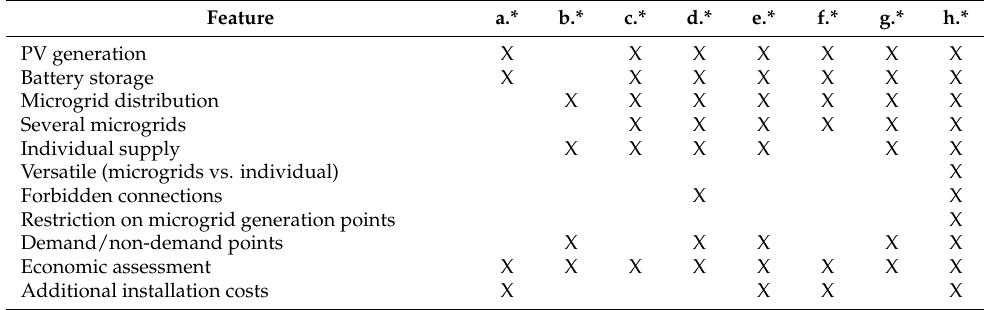
Table 1. Comparison of main problem features addressed in this study and in previous related works.